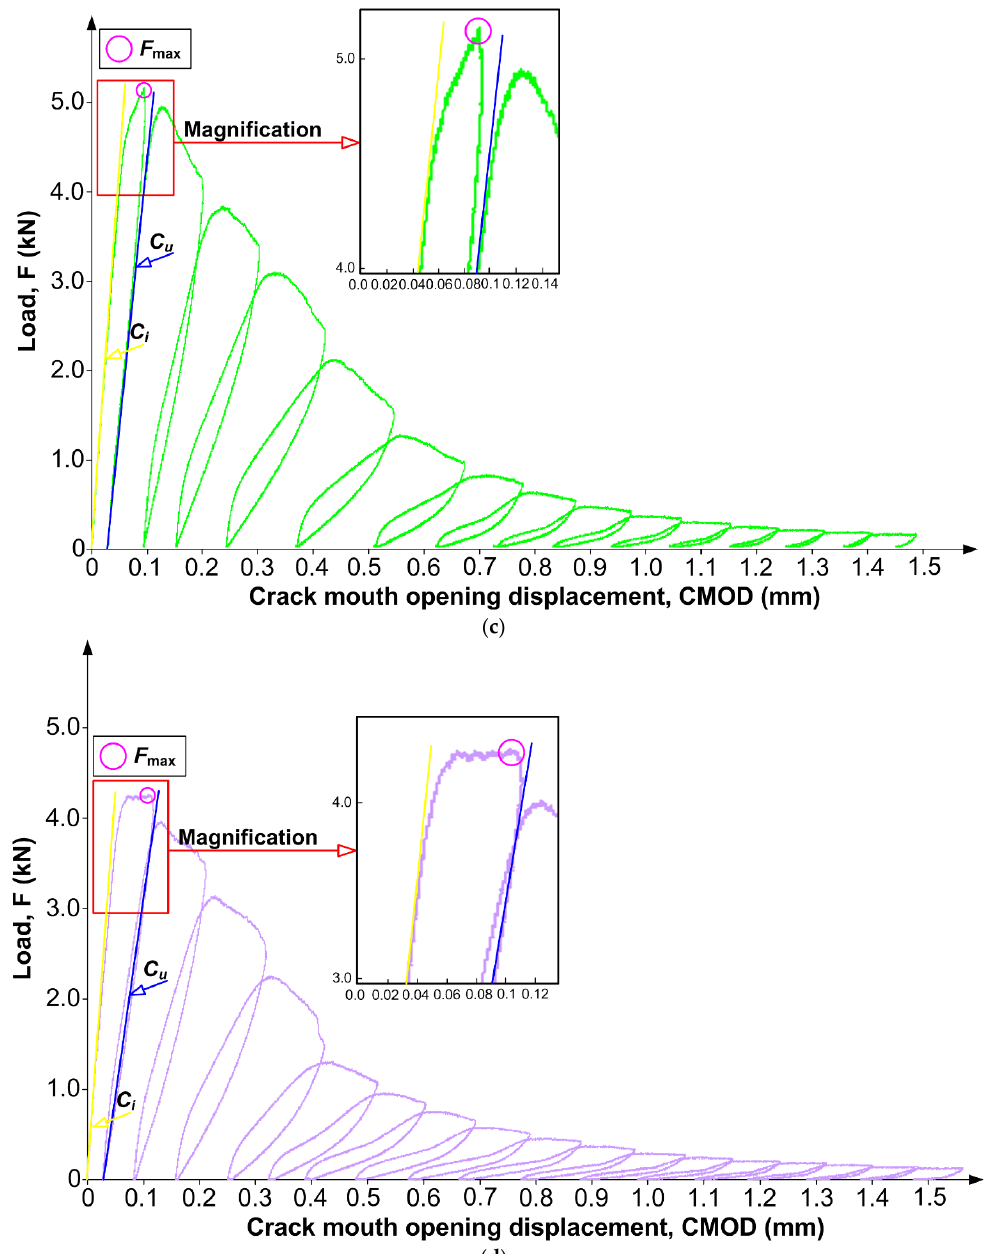
Figure 3. Exemplary load vs. CMOD curves for the analyzed concrete composites: ( a ) REF, ( b ) QBC-1, ( c ) QBC-2, ( d ) QBC-3.